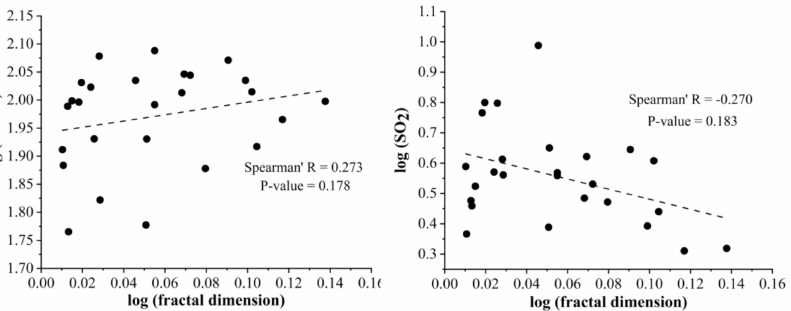
Figure 4. Fitting results between fractal dimensions of metro networks and air pollution